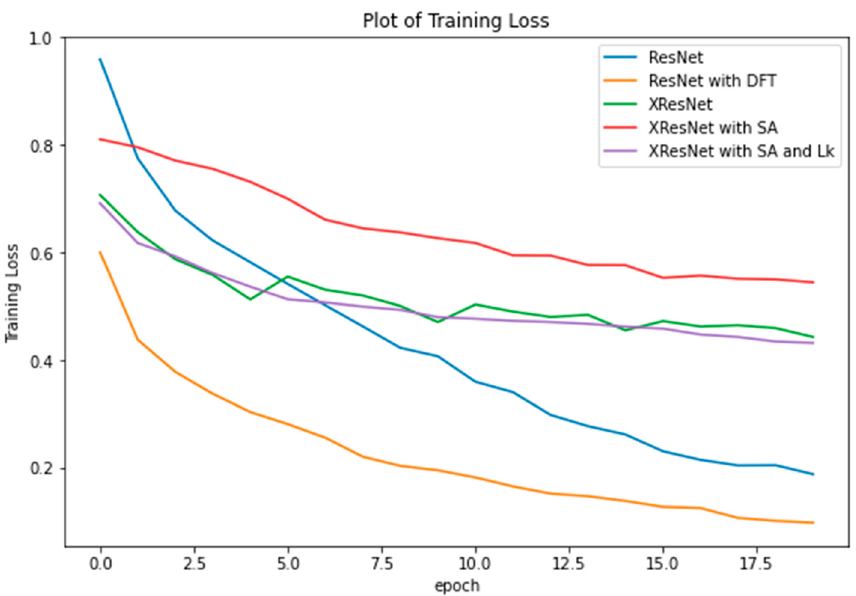
Figure 5. Training Loss of ResNet trained from scratch, ResNet fine-tuned using DFT, XResNet initialized with pre-trained weights, XResNet with self-attention trained from scratch, and XResNet with self-attention and lookahead optimizer.